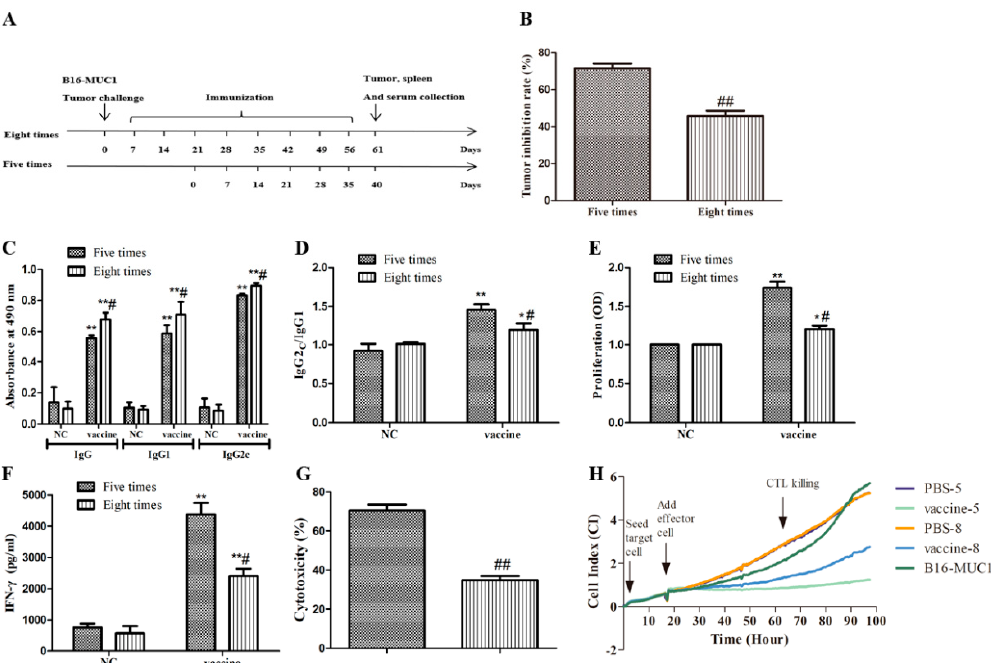
Figure 6. The e ff ect of immunization cycles of the recombinant MUC1-MBP vaccine on the T cell response to B16-MUC1 melanoma in the therapeutic mouse model. ( A – H ) Mice ( n = 5) first were subcutaneously (s.c.) injected with B16-MUC1 melanoma cells on day 0, and then were immunized with the vaccine five or eight times at 7-day intervals. On the fifth day after the final immunization, the mice were euthanized and the tumor, serum, and spleen were collected for the tumor inhibition rate assay, the MUC1-specific antibody, the cell proliferation assay, and the MUC1-specific CTL killing activity assay. ( A ) The experimental workflow of the mouse therapeutic model. ( B ) The tumor inhibition rate. Tumor inhibition rate (%) = (1 − experimental group tumor weight / control group) × 100%. ( C ) MUC1-specific IgG, IgG1, and IgG2c levels in the sera of the immunized mice were determined using ELISA. ( D ) Serum IgG2c / IgG1 ratio. ( E ) Lymphocyte proliferation was measured by the WST-1 assay. ( F ) The IFN- γ secretion was measured by ELISA. (G,H) MUC1-specific CTL-killing activity was measured by an RTCA. ( G ) CTL-killing activity, cytotoxicity (%) = (1 − CI (vaccine group) / CI (NC group)) × 100%. ( H ) The dynamic change in the cell index (CI); * p < 0.05, ** p < 0.01 vs. the NC group. # p < 0.05, ## p < 0.01 vs. the group immunized five